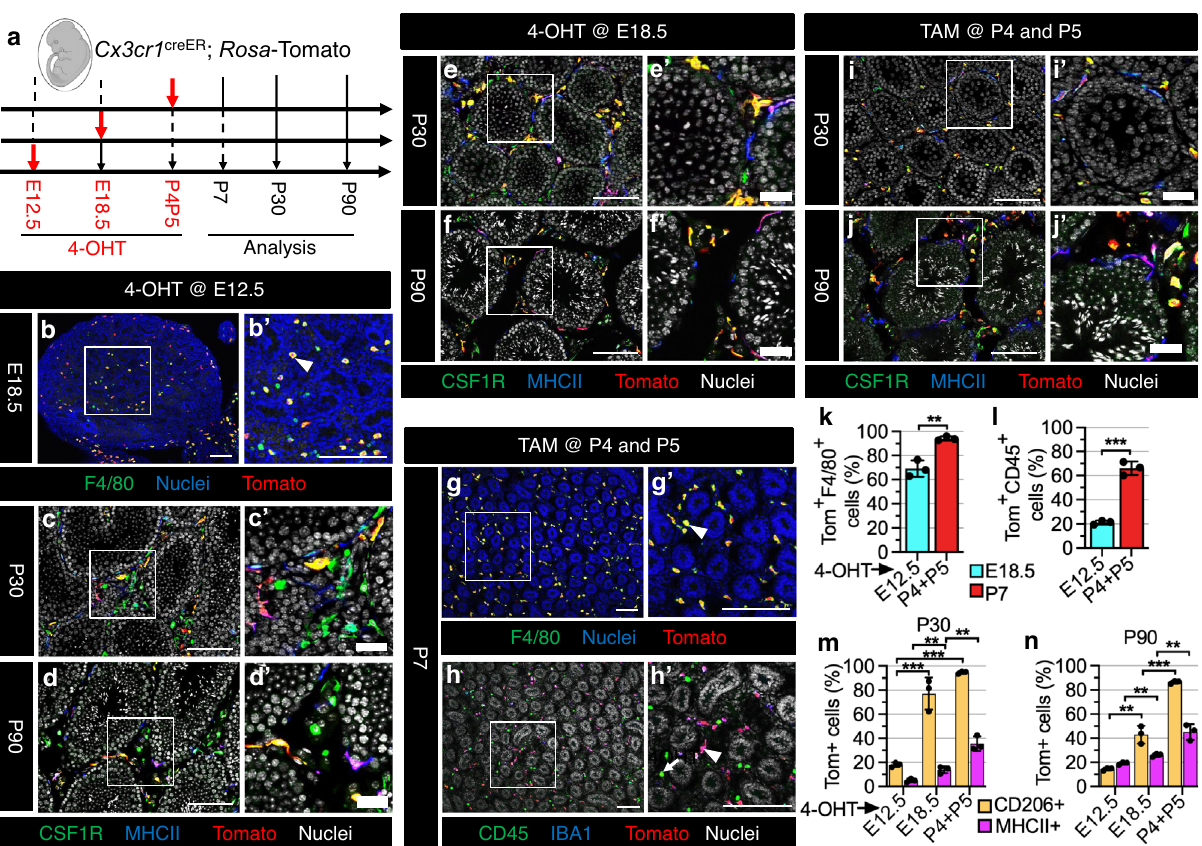
Fig. 4 | Fetal testis monocytes gradually differentiate into testicular macro- phagesafterbirth.a Strategyfor4-OHT-inducedlineage-tracingandharvestingof testesfrom Cx3cr1 creER ; Rosa -Tomatoembryosandjuvenile/adultmice.Theembryo image was created with BioRender.com software (BioRender.com). b – j Representative images ( n =3 independent gonads) of testes at various stages from Cx3cr1 creER ; Rosa -Tomatomiceexposedto4-OHTatE12.5( b – d ),E18.5( e , f ),or to TAM at P4 and P5 ( g – j ). Arrowheads denote Tomato-expressing IBA1 + or F4/80